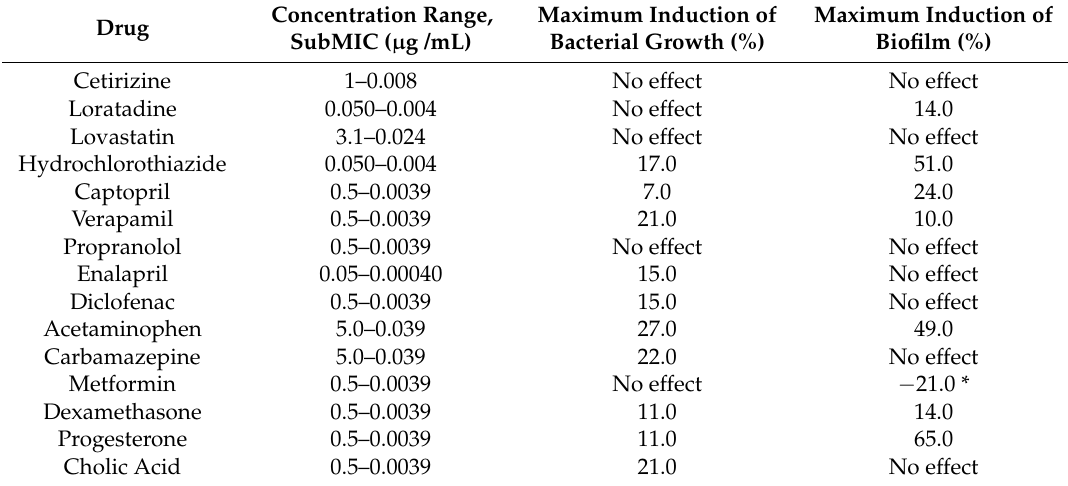
Table 3. Effect of some drugs on bacterial growth and biofilm